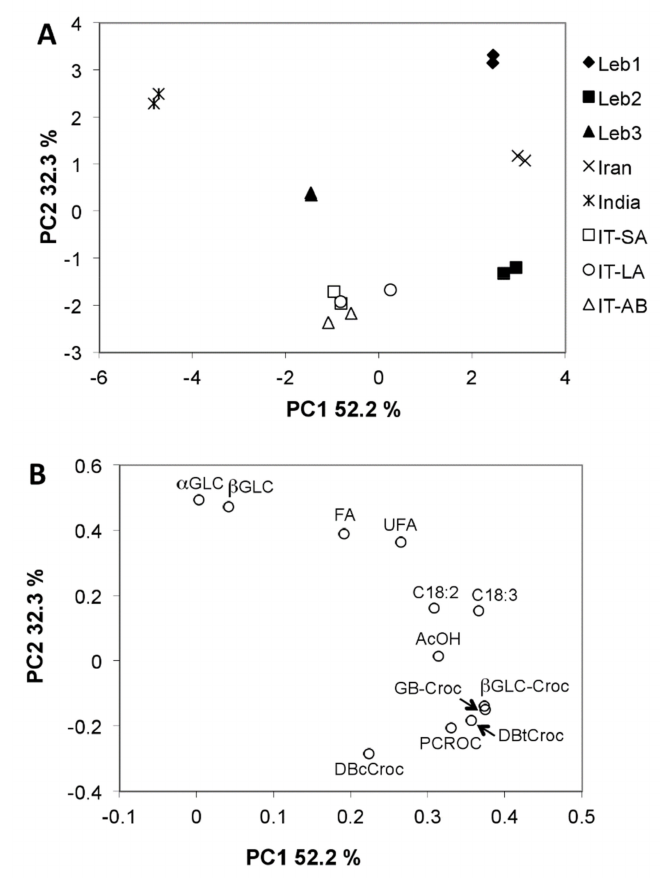
Figure 3. PCA scores ( A ) and loadings ( B ) plots of NMR metabolite profiling